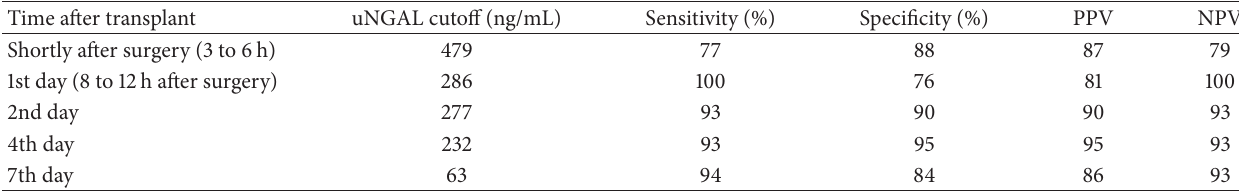
Table 4: Sensitivity, specificity, and predictive values for DGF using specific uNGAL cut-off